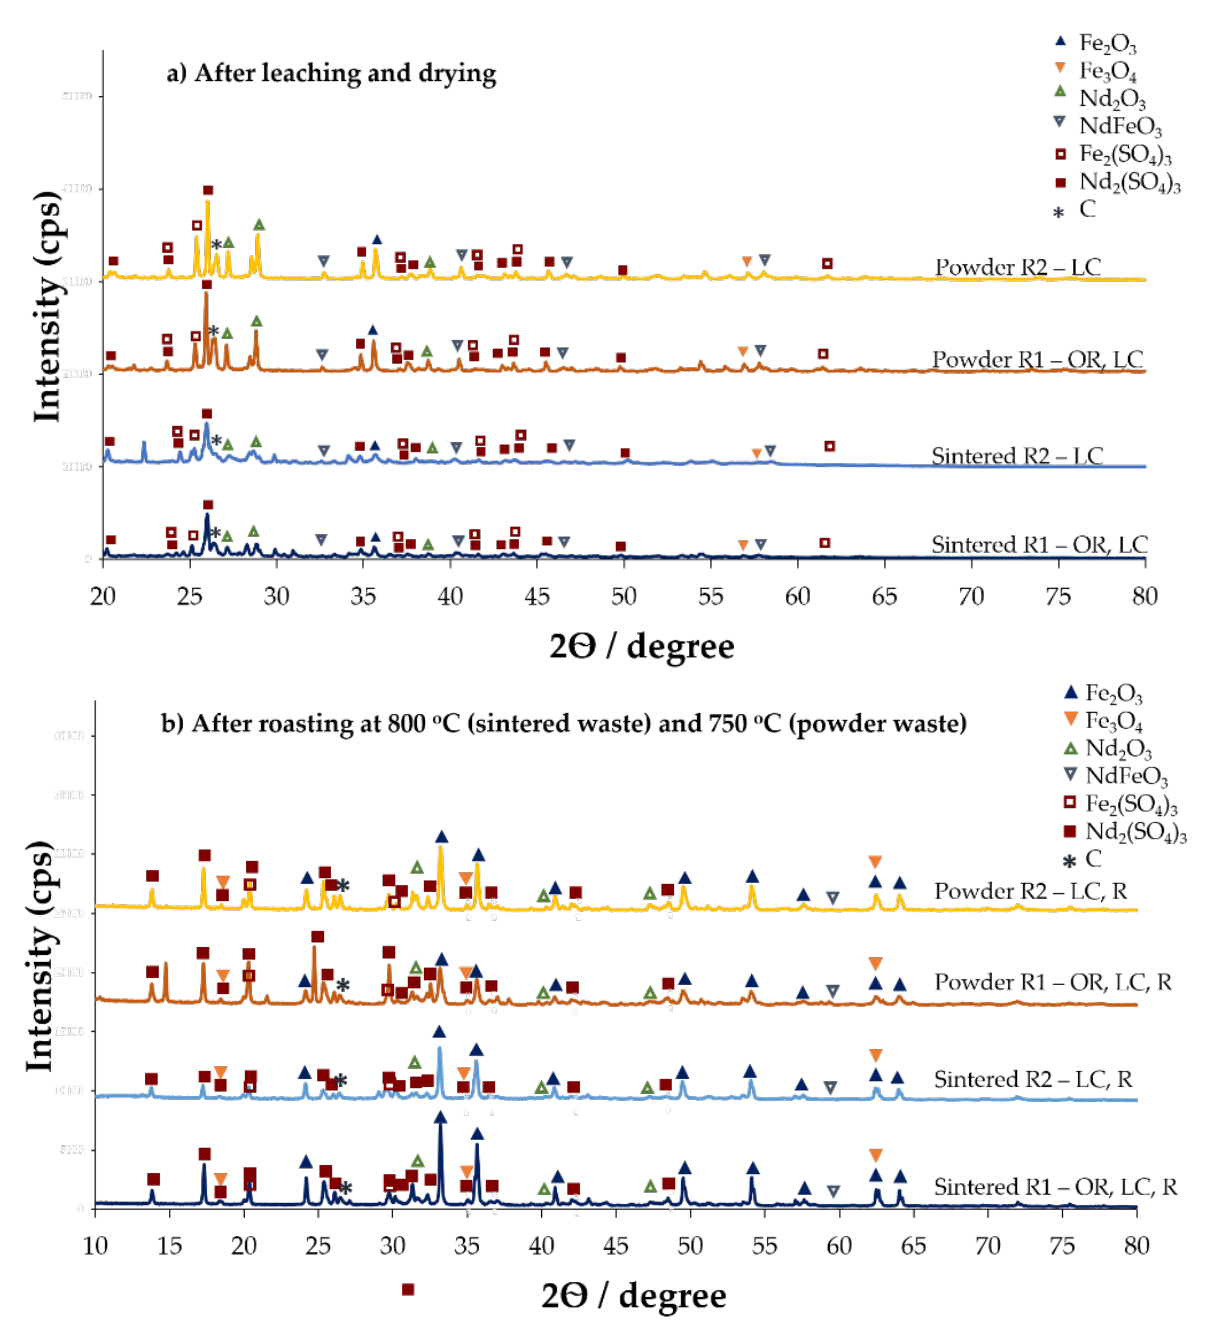
Figure 7. Products obtained via route I and route II recycling of sintered wastes, ( a , b ) after leaching, drying and roasting at 800 °C/2 h, ( c , d ) after precipitation and calcination